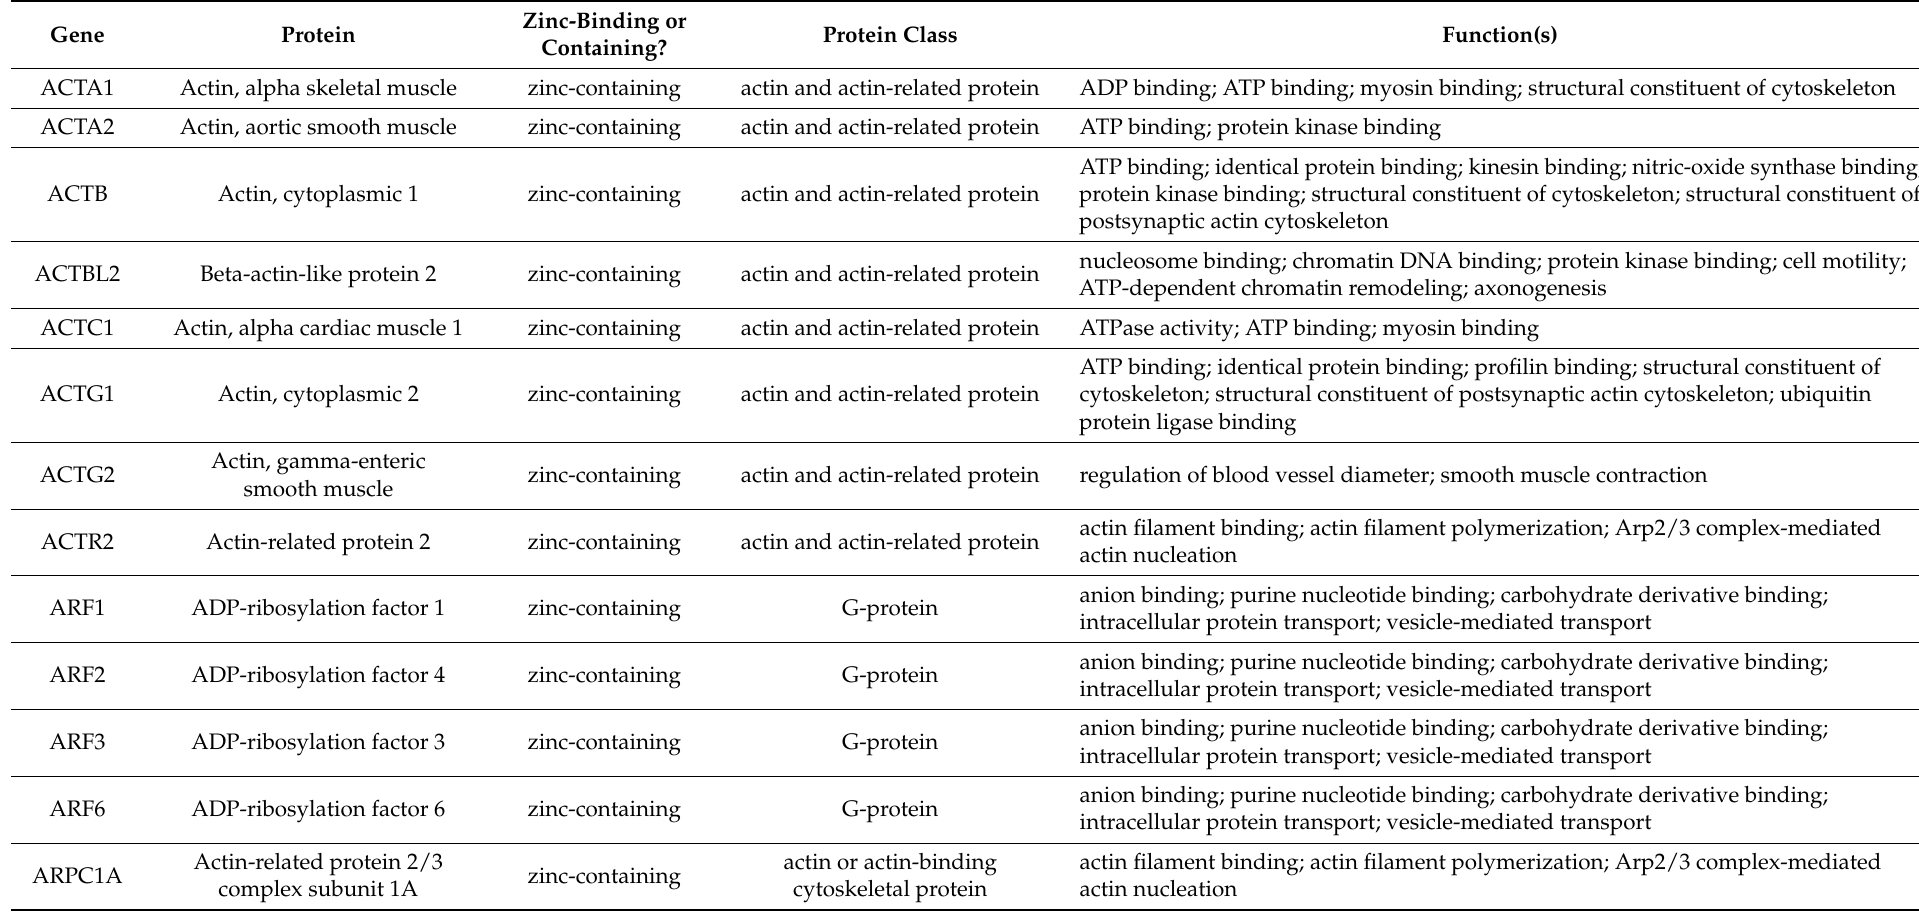
Table 3. Identified boar sperm zincoproteins of the HD pathway. Proteins were classified according to PANTHER classification system (http://pantherdb.org/) (accessed on 3 May 2021). Function(s) of the proteins were taken from the UniProtKB database (https://www.uniprot.org/), accessed on 3 May